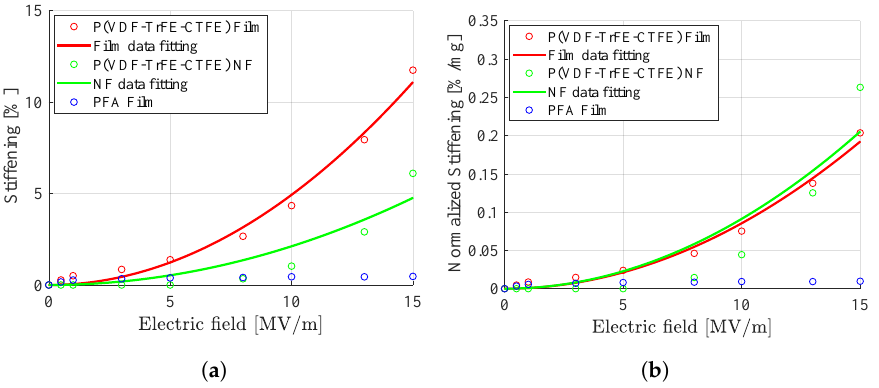
Figure 14. Uniaxial tensile load test for the P(VDF-TrFE-CTFE) film, the P(VDF-TrFE-CTFE) NF nanofiber mat, and the PFA film. ( a ) Stiffening plot. ( b ) Normalized stiffening plot.